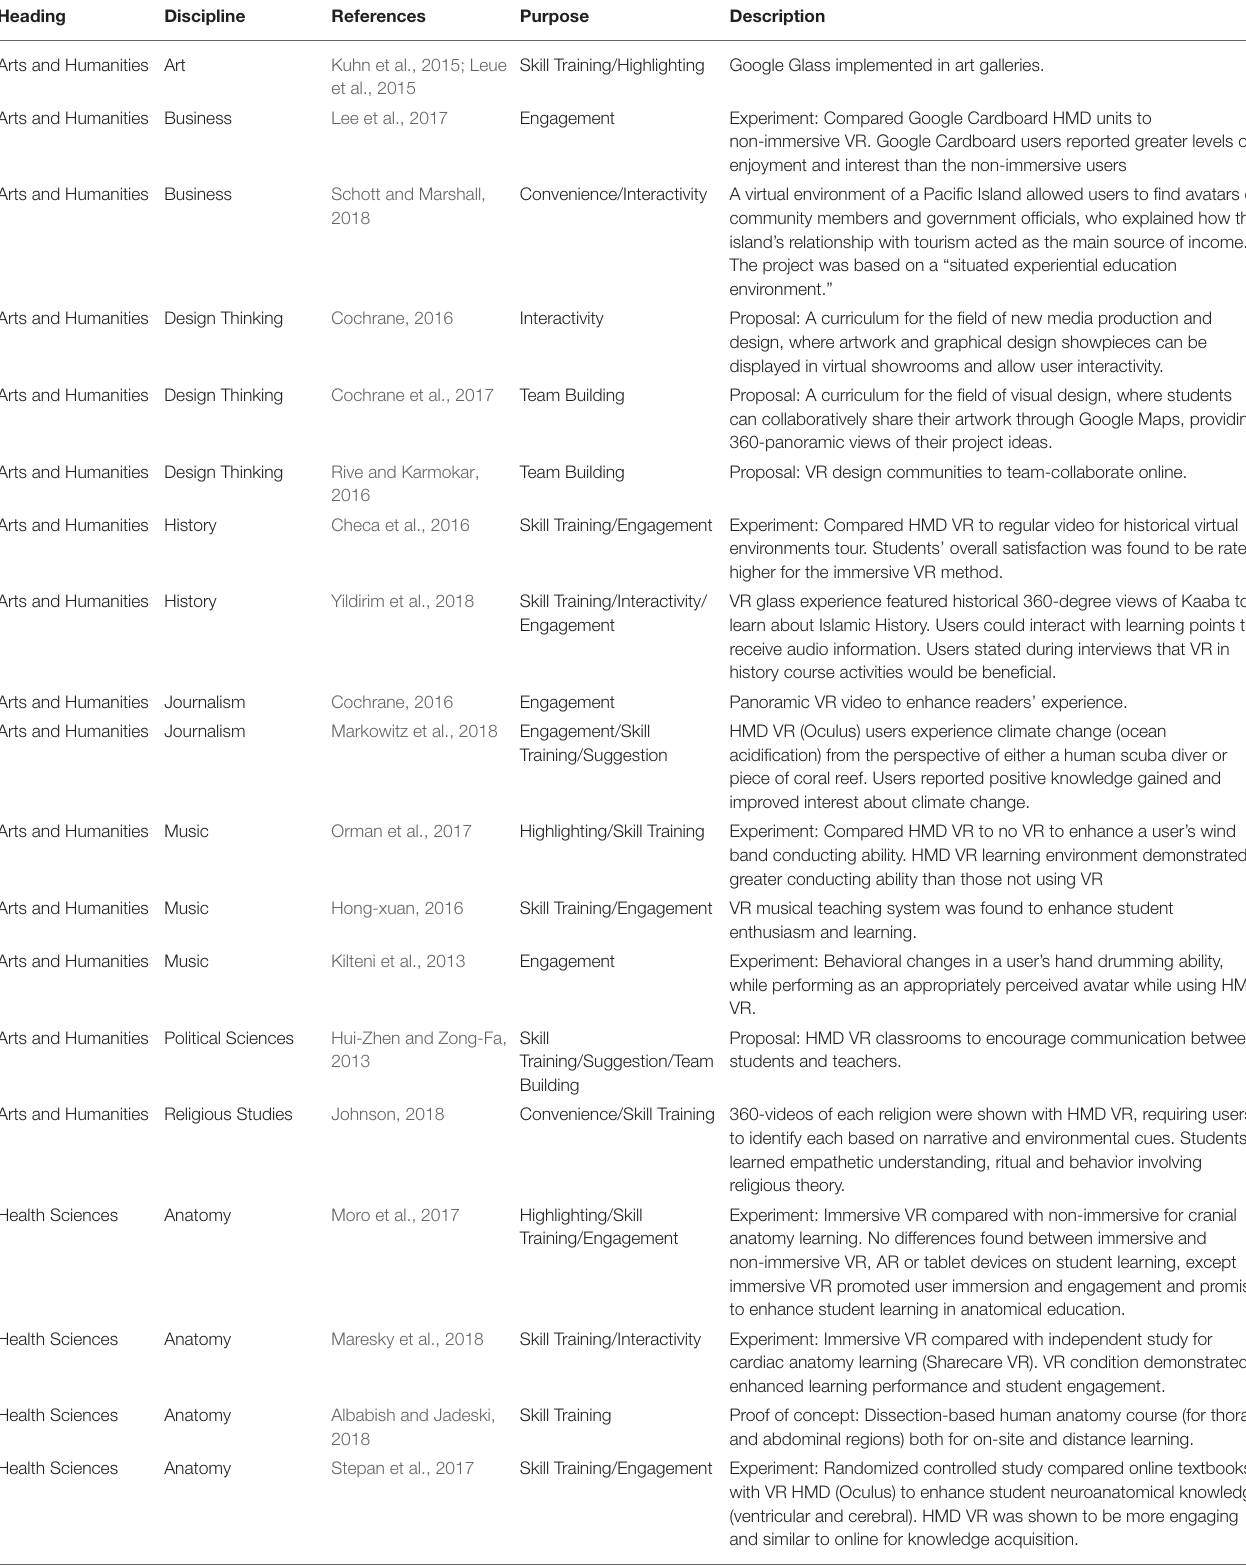
TABLE 5 | Literature summary of immersive VR usage across educational